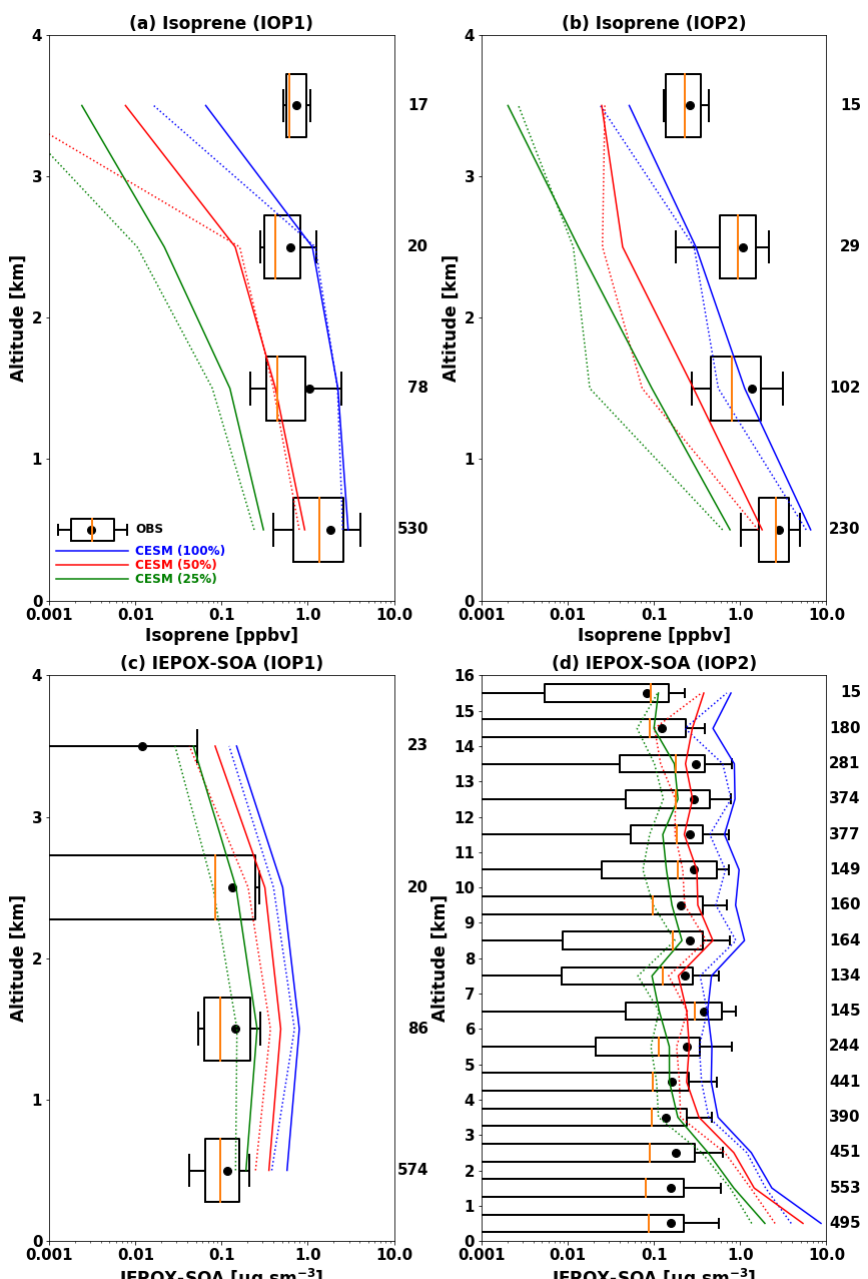
Figure 2. Vertical profiles of isoprene (a, b) and IEPOX SOA (c, d) during the GoAmazon (a, b, c) and ACRIDICON-CHUVA (d) campaigns. Profiles are binned to the 1km vertical resolution. Boxes show the 25th–75th percentile, with the orange line showing the median. Whiskers represent the 10th and 90th percentiles and the black dot indicates the mean value. The model results are shown in blue, red, and green for the base, half, and quarter isoprene emissions from tropical tree PFTs, respectively. The solid line represents the mean, and the dashed line indicates median values. The observed median and quartile values are not visible at the 3–4km level in (c) , as they are smaller than 0.001µgm − 3 . The number of data points in each kilometer interval is shown at the right of each panel.